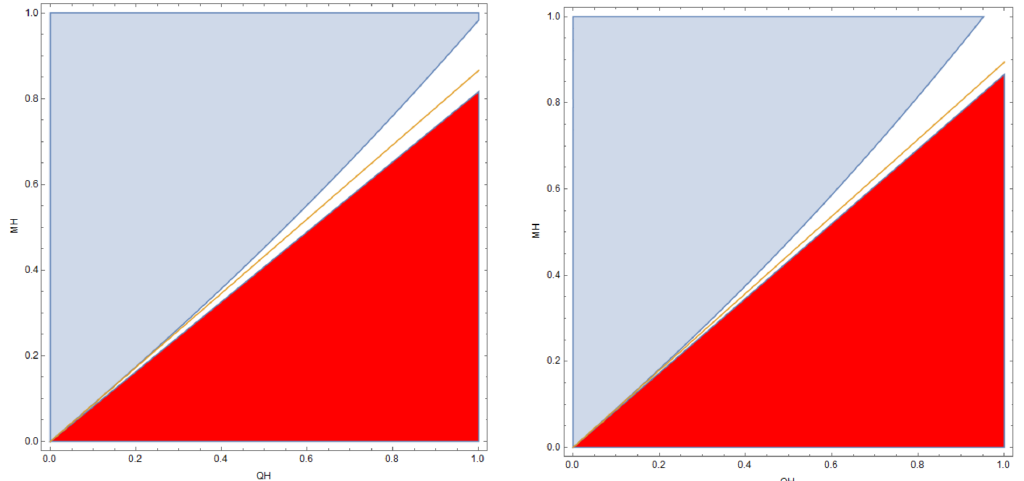
Figure 5 . The dilatonic AdS black hole case. The left panel describes the phase diagram for the α 2 = 1 / 3 , the right panel shows the explicit example of α 2 = 1 / 4 to illustrate the situation for α 2 < 1 / 3 . In both cases, the blue region corresponds to black hole solutions, the yellow line is the flat-space discriminant between shielded and naked singularities (playing no role here but shown for comparison) and the red region is the inaccessible region where the metric becomes